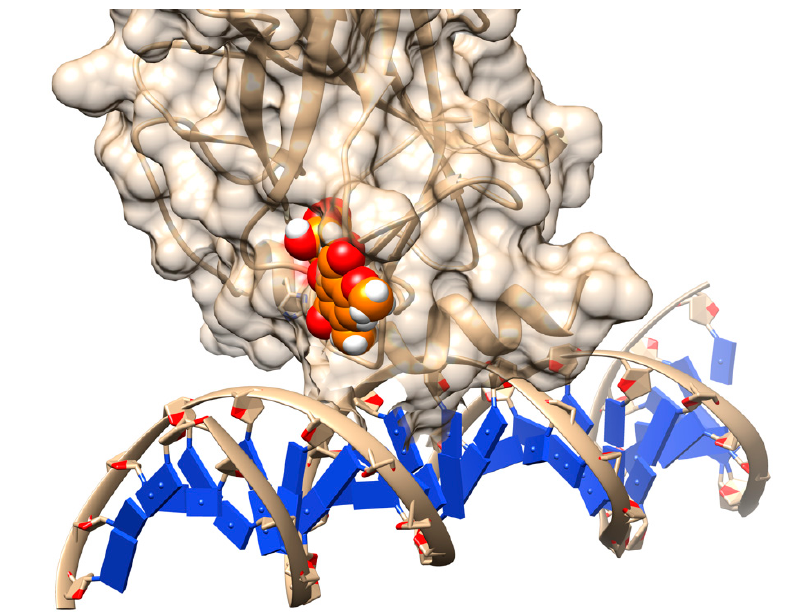
Figure 5. Rescuing the activity of mutant p53 by binding stictic acid into the open L1/L3 pocket. The representative scheme is generated using the structure of p53 core domain complex with DNA (PDB: 1TSR). Atoms in sphere representation belong to stictic acid in a given docked pose (hetero atoms colored as per the default coloring scheme of Chimera). The DNA bases are represented as blue squares.